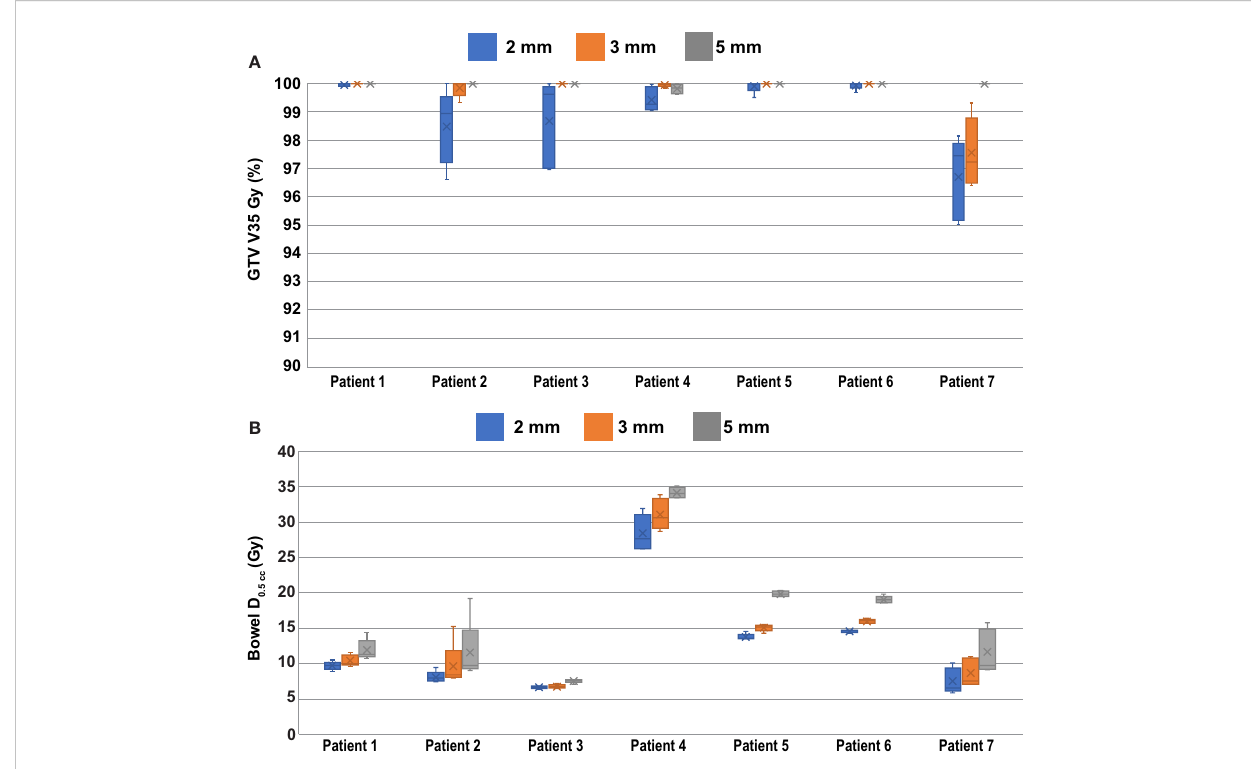
FIGURE 3 Per Patient Dosimetric Statistics. (A) GTV V 35 Gy coverage to the PTV when accounting for the effects of intra-fraction motion. (B) Bowel D 0.5cc doses as calculated on the daily ATS